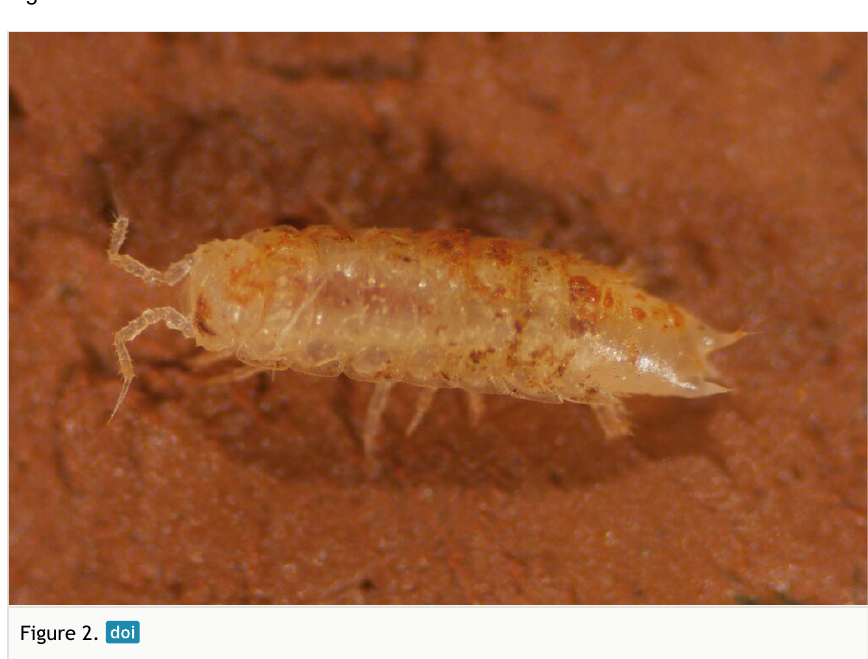
Figure 2. Miktoniscus longispina Reboleira & Taiti, 2015 from Cerâmica Cave in Sicó karst